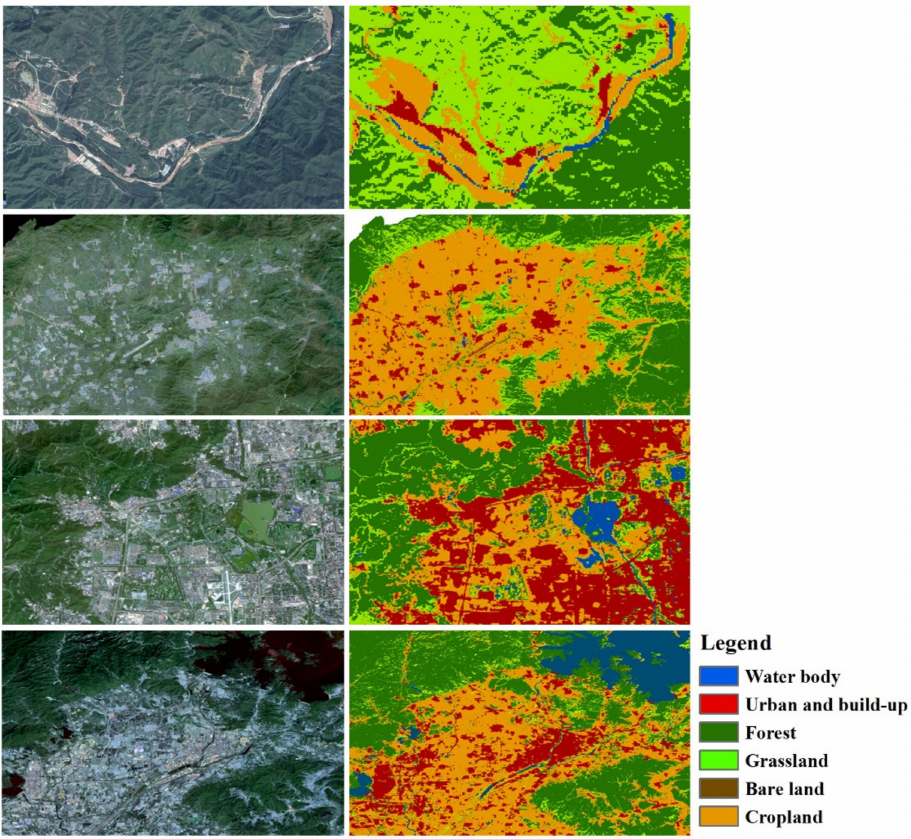
Figure 8. Details of Beijing land cover product produced using ARD (left: satellite image; right: land cover